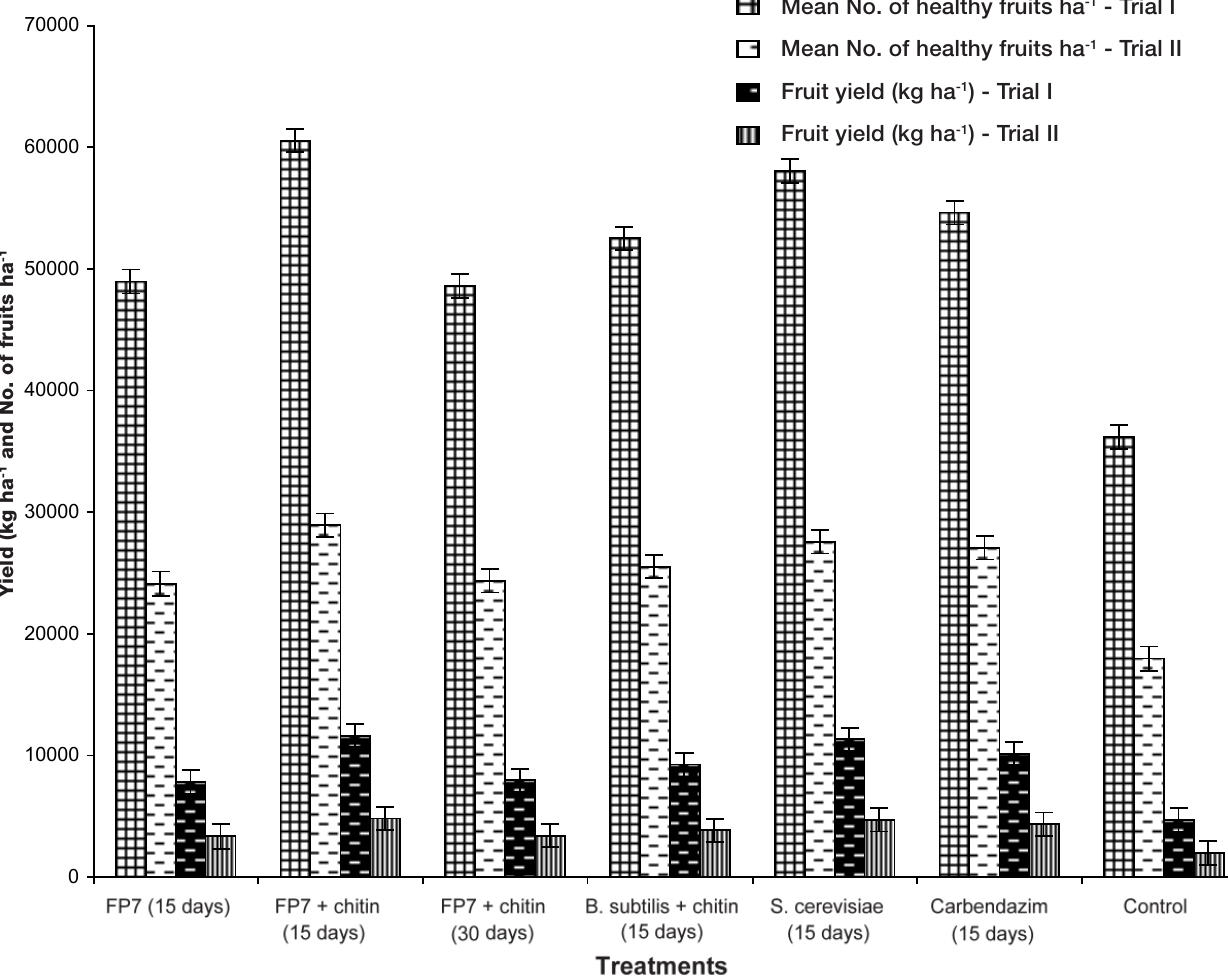
Fig. 2. Effect of pre-harvest application of Pseudomonas fluorescens strain FP7 with chitin biocontrol formulation on flower initiation and anthracnose incidence in